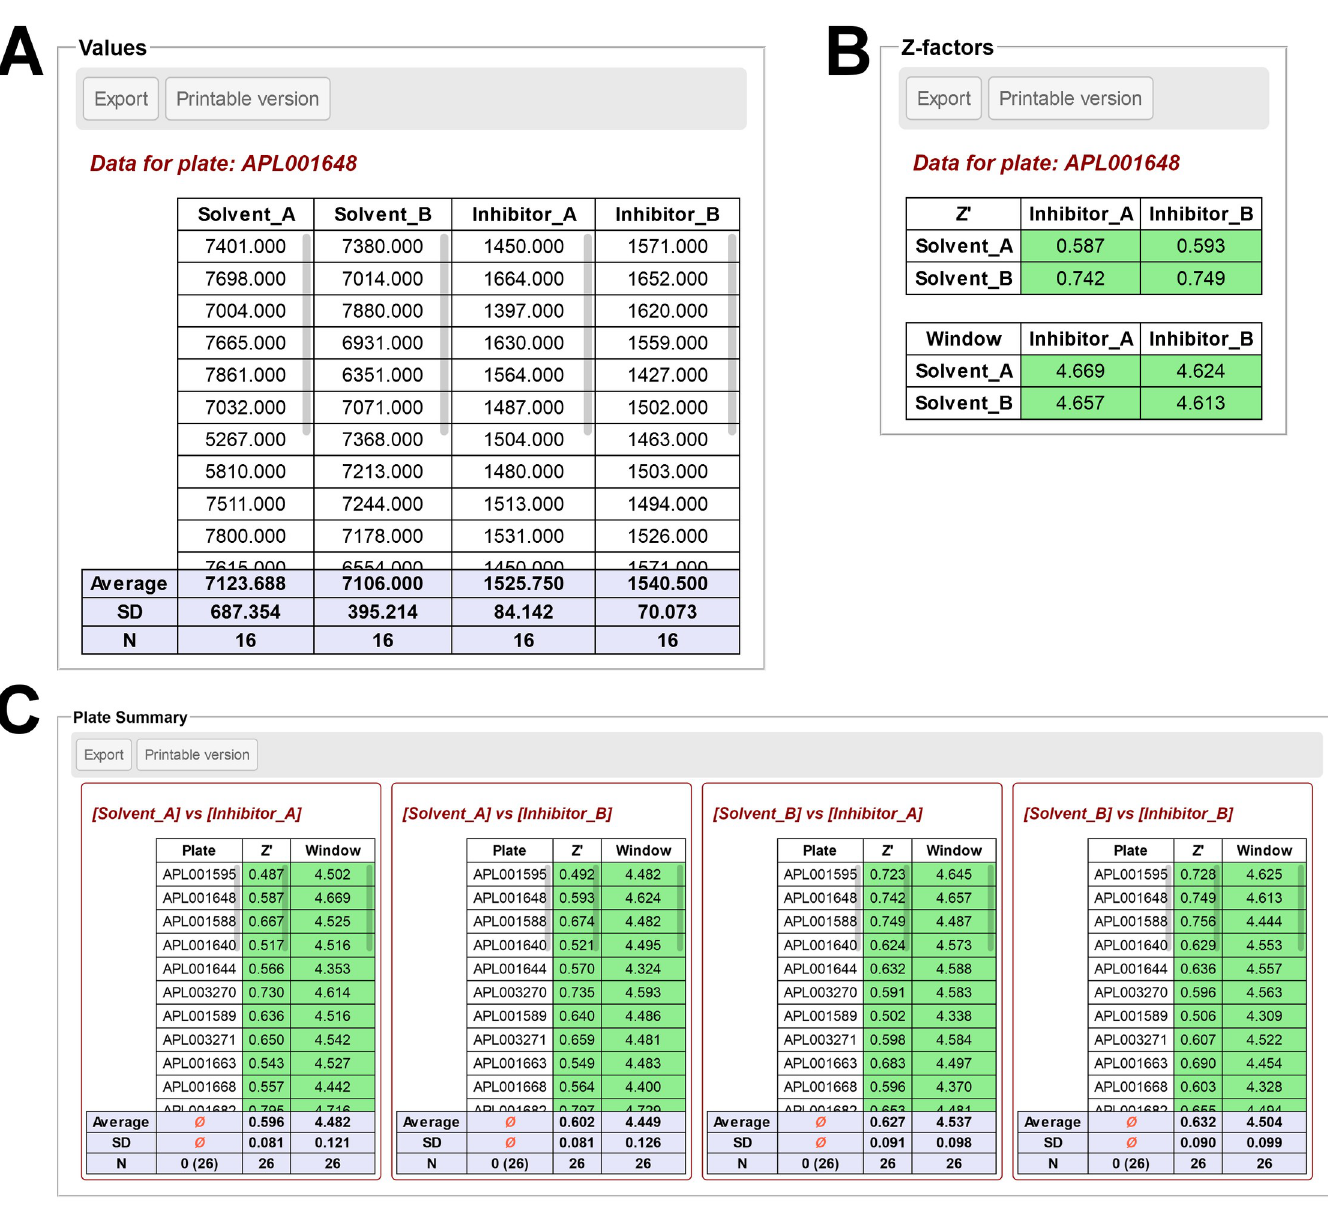
Fig 3. Overview of the Controls analysis tool outputs, for a layout including two positive (Inhibitor_A, Inhibitor_B) and two negative (Solvent_A, Solvent_B) controls. A . Individual values for each control are aggregated in columns, with their average and standard deviation (SD) computed. N indicates the number of values. B . Calculated Z-score (Z’) and Window for all combinations of positive and negative controls (as double-entry tables) for the plate currently selected. C . Summary values (Z’, Window) for all visited plates are aggregated in columns, with their average and standard deviation (SD) computed. N indicates the number of plates visited. Values for each positive/negative control combination are indicated in separated tables. This figure can be reproduced using the files from the Screening